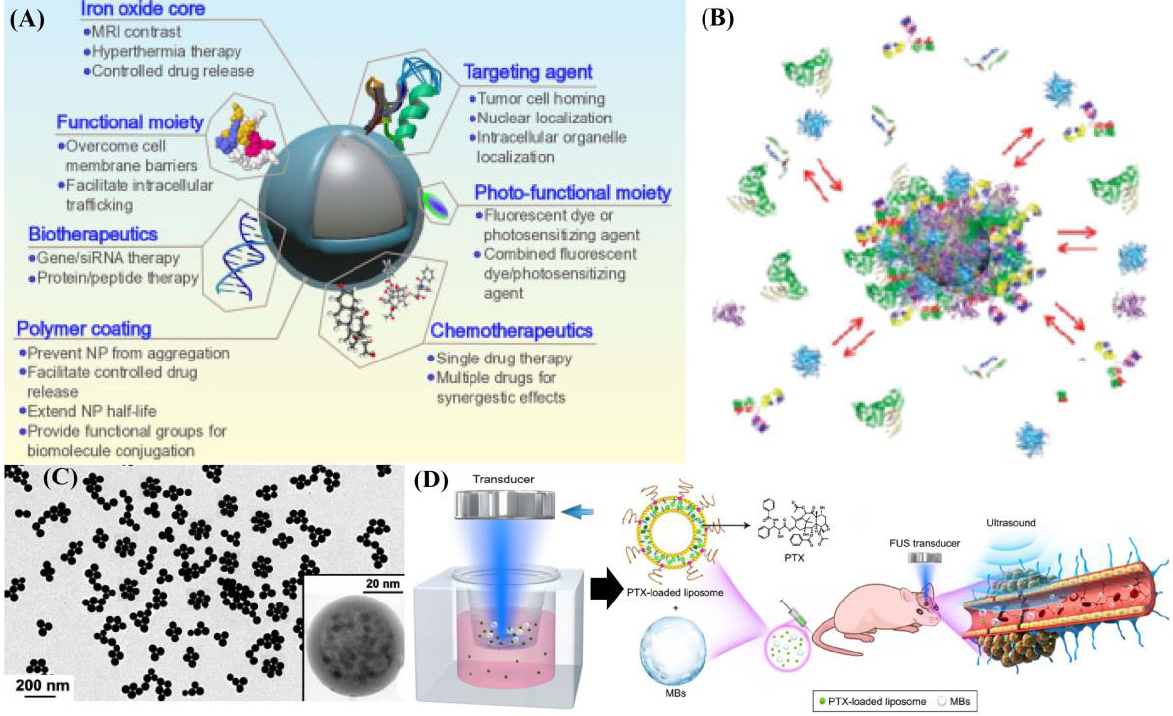
Figure 3. ( A ) Schematic illustration of a full-suite theranostic NP. The magnetite core serves as an MRI contrast agent and heat source for magnetic hyperthermia, and a polymer coating increases biocompatibility, mitigates RES uptake, and allows for facile functionalization with chemotherapeutic, biotherapeutic, and optical enhancement, and targeting moieties. ( B ) Schematic drawing of the structure of protein-nanoparticles in blood plasma confirming the existence of various protein binding (e.g., an outer weakly interacting layer of protein (full red arrows)) ( C ) Mono-disperse superparamagnetic nano spherical composites with a core containing metallic α-Fe nanocrystals dispersed in a silica matrix, and a shell only containing silica. ( D ) The effect of FUs with MBs on the permeability of the in vitro BBB mode and schematic illustration outlining the delivery of PTX-lIPO using FUs exposure in the presence of circulating MBs. These are reprinted with permission from Mahmoudi et al. (2011, Elsevier), Shen et al. (2017, Dove Press), Tartaj et al. (2003, Elsevier), and Revia et al. (2015, Elsevier), respectively.